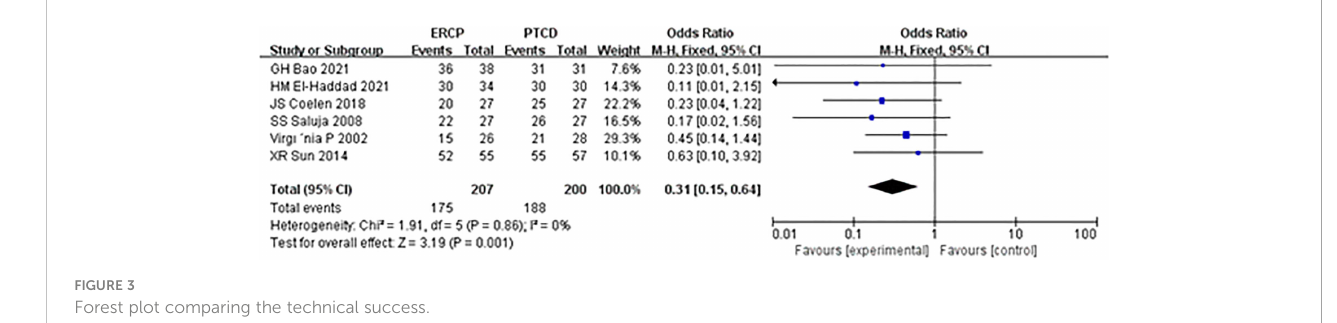
FIGURE 3 Forest plot comparing the technical